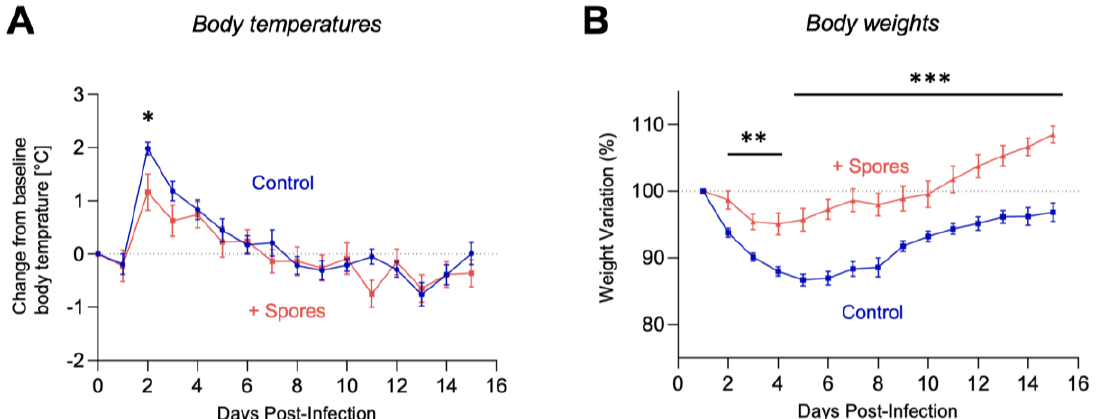
Figure 2. Change in body temperature and weight loss exhibited by ferrets treated with DSM 32444 K or mock treated with PBS following infection with H7N9 AIV. Ferrets were treated with 0.5 mL of DSM 32444 K (red line) or PBS (blue line) on four separate occasions, 7 days apart, followed by infection with H7N9 AIV 7 days after the last treatment. Individual values were plotted per animal, and lines indicate the mean values per group. Body temperatures and weights taken 1 day prior to infection were used to configure a baseline, and then, temperatures (panel A ) and weights (panel B ) were taken daily following infection with H7N9 AIV. Statistical significance was determined using a two-tailed Mann-Whitney U test; panel A, * p < 0.05; panel B, ** p < 0.01, *** p < 0.001.